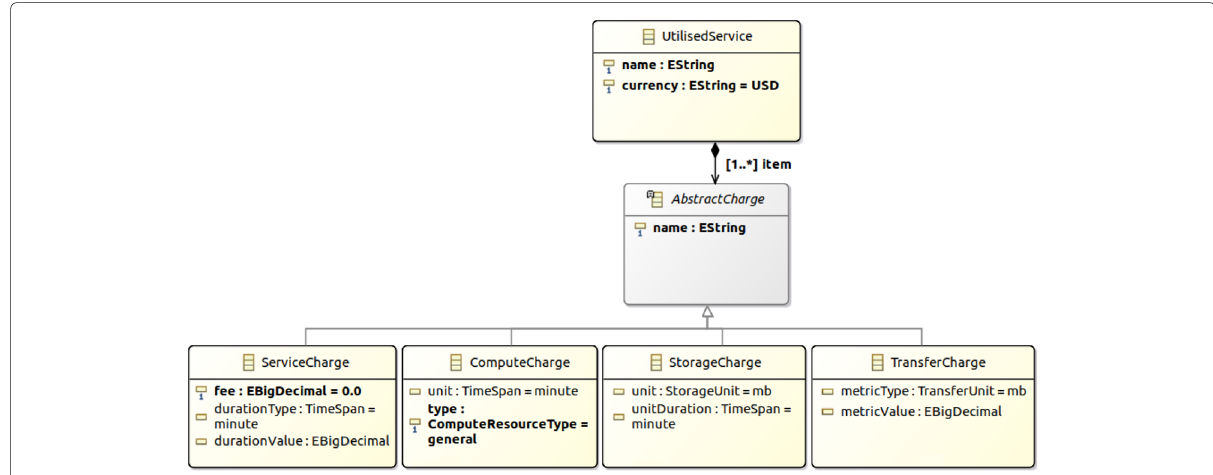
Fig. 4 A snippet of the cloud cost metamodel showing its key